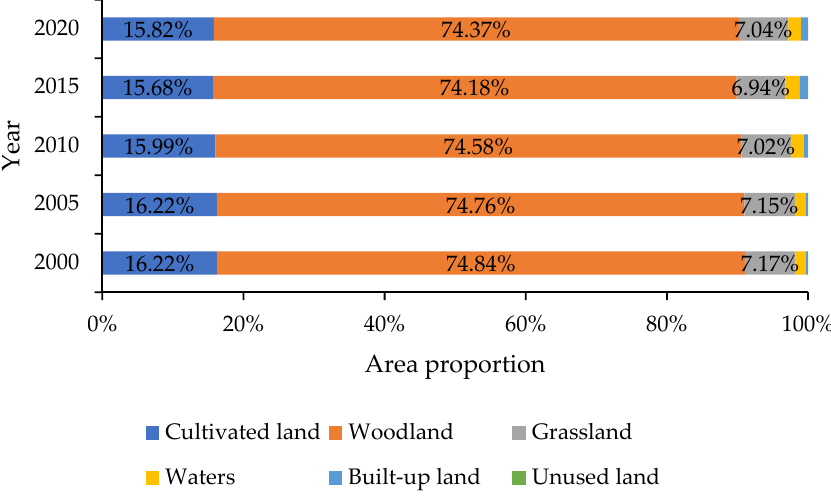
Figure 3. Area percentage of land use types in Shiyan from 2000 to 2020.